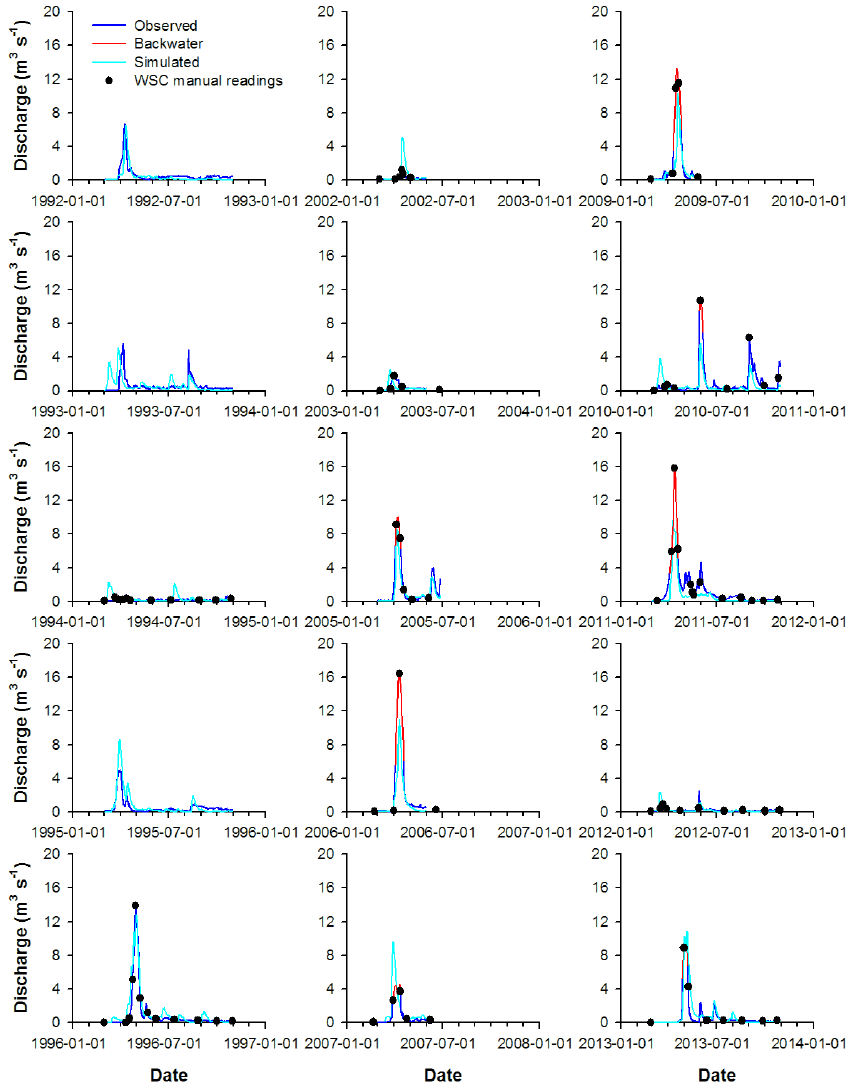
Figure 3. Comparison of observed and simulated stream discharge between 1992 and 2013 for years with good records in the HYDAT